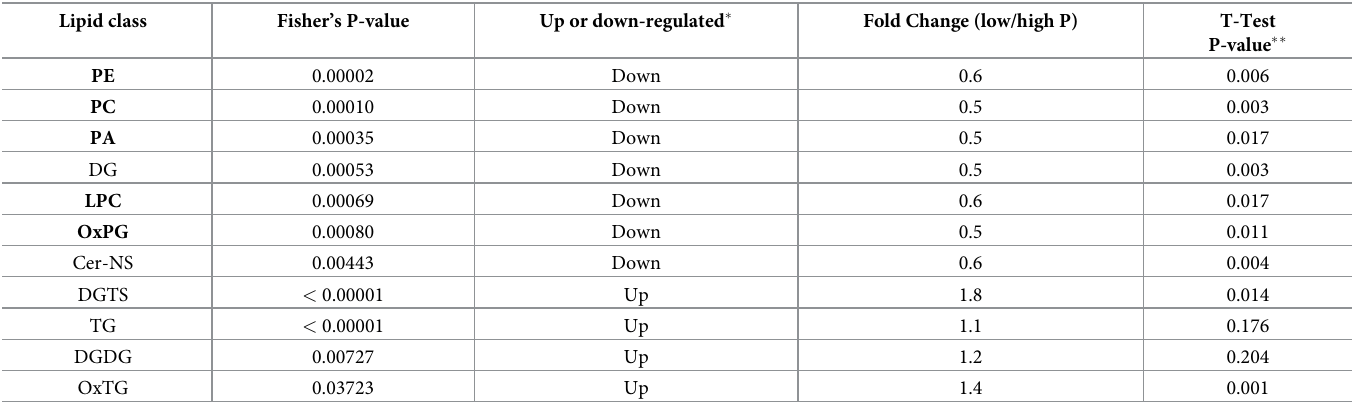
Table 2. Selected up- and down-regulated lipid classes based on a fisher’s exact test.